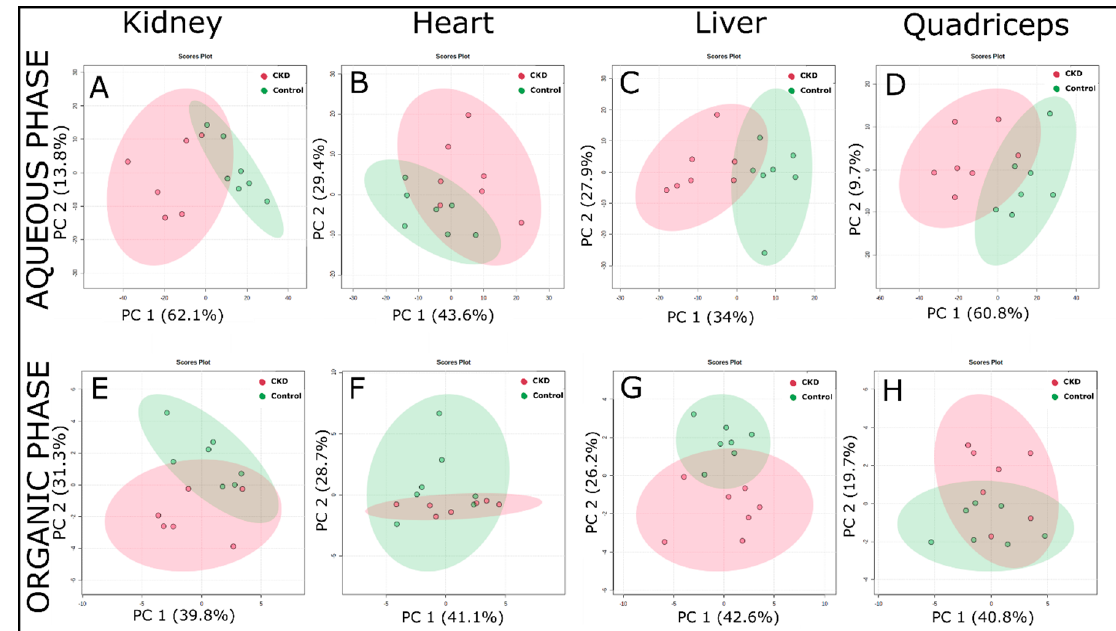
Figure 3. Principal component analysis (PCA) analysis of the 1 H-NMR spectra of the extracted tissue samples (using a targeted profiling approach) from control and adenine-induced CKD groups. ( A-D ) PCA score plots from the aqueous phase samples for the kidney, heart, liver, and quadriceps, respectively. ( E-H ) PCA score plots from the organic phase samples in the same order as mentioned above ( n = 7/group).